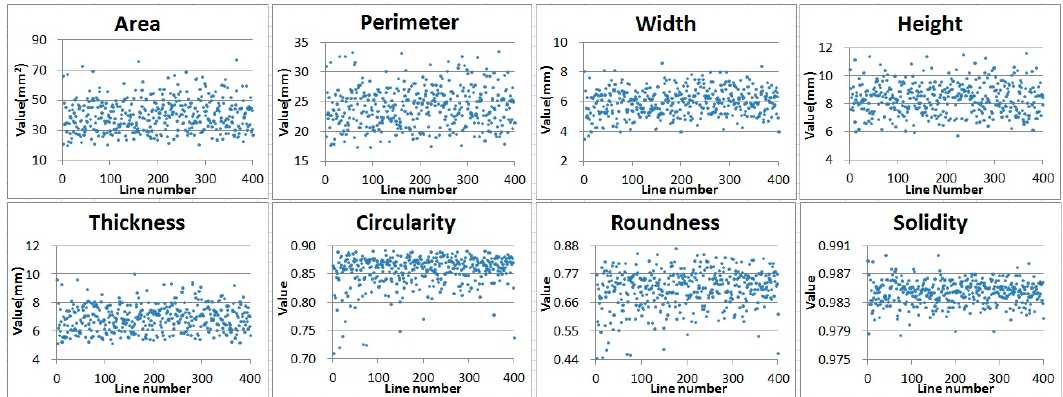
Figure 3. Distribution of morphological data measurement of 400 lines. It is a distribution chart that calculates the average area, perimeter, width, height, thickness, circularity, roundness, solidity of each lines.